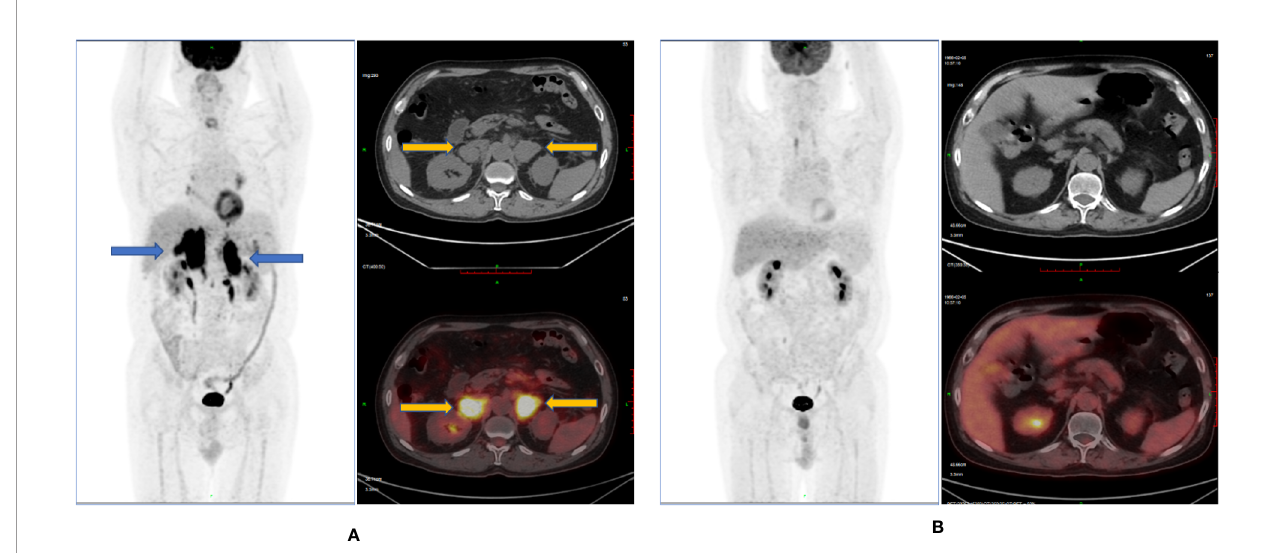
FIGURE 3 | Remission status r/r DLBCL after anti-CD19 CAR-T-cell therapy and sirolimus. (A) Full-body 18 FDG-PET scan pre- anti-CD19 CAR-T-cell therapy. (B) full-body 18 FDG-PET scan post- anti-CD19 CAR-T-cell therapy.